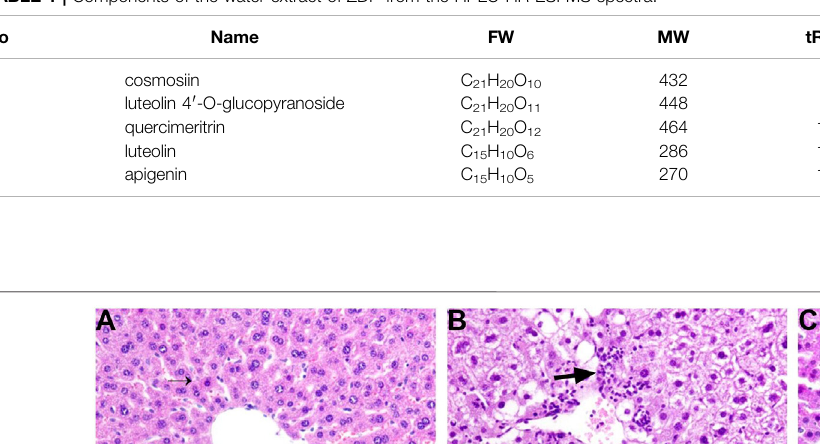
TABLE 1 | Components of the water extract of ZDP from the HPLC-HR ESI MS spectra.